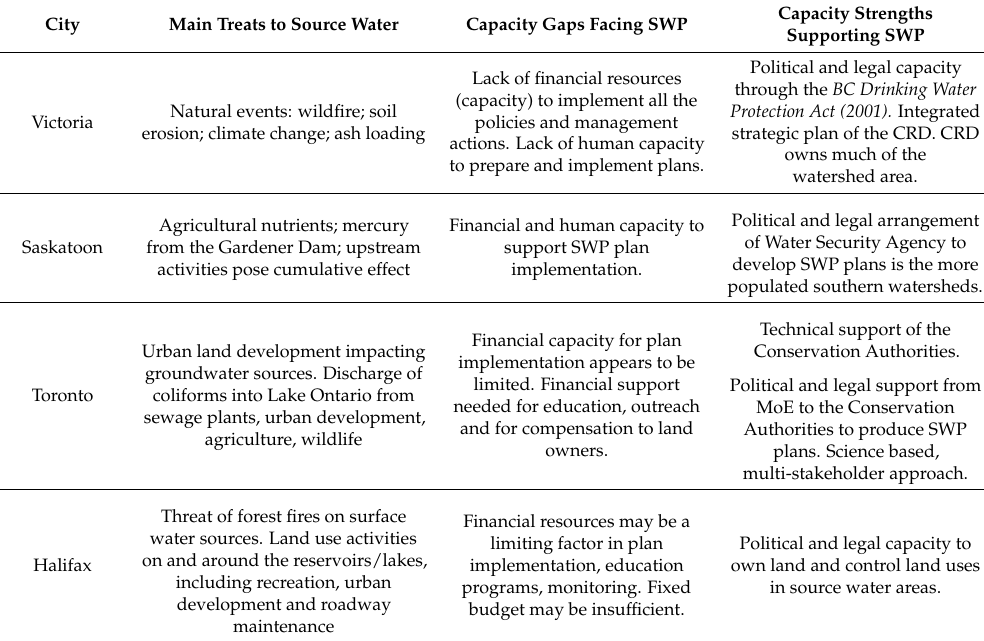
Table 2. Case study capacity needs for SWP